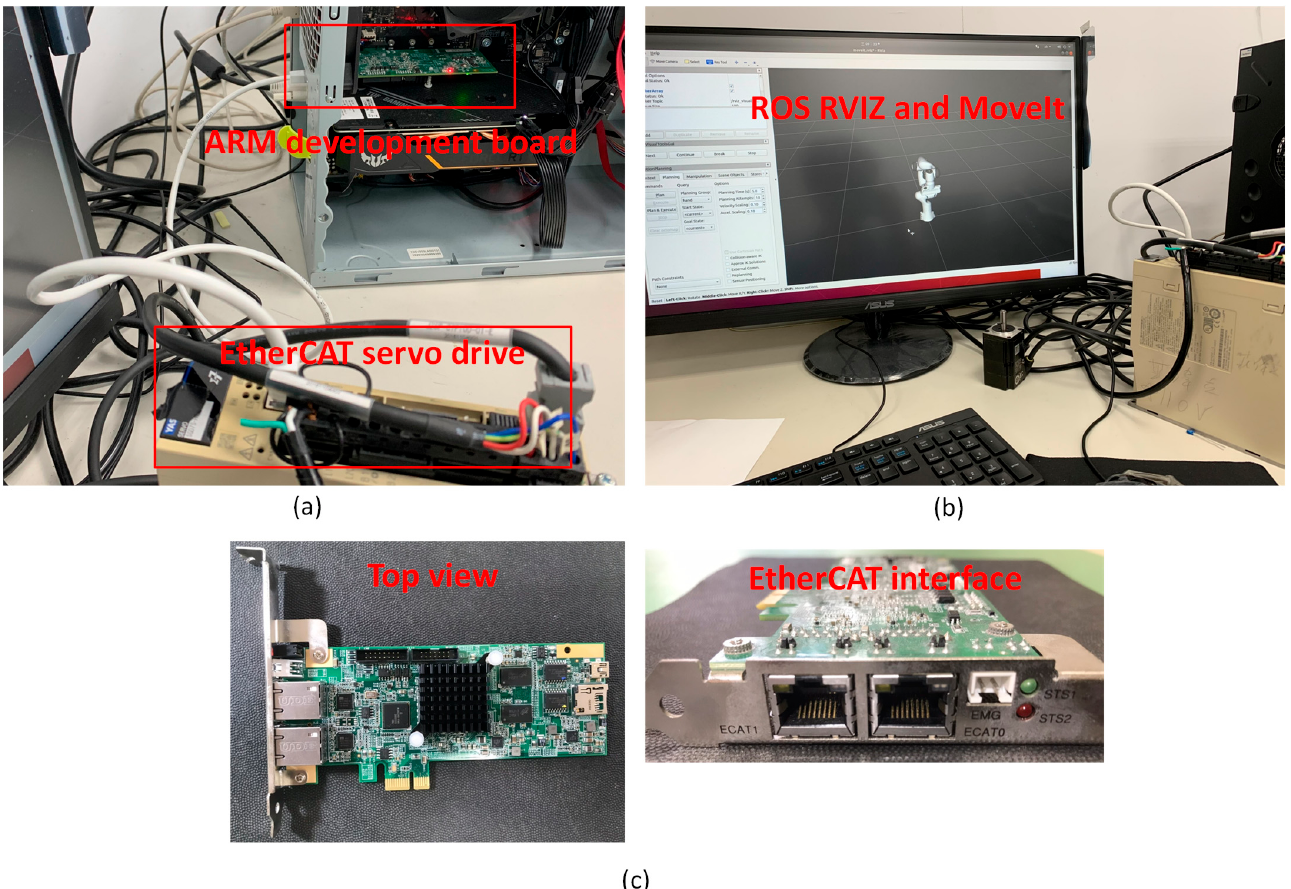
Figure 3. Overview of test devices in laboratory for experiments: ( a ) ARM development board and EtherCAT servo drive. ( b ) ROS RVIZ and MoveIt. ( c ) ARM development board near